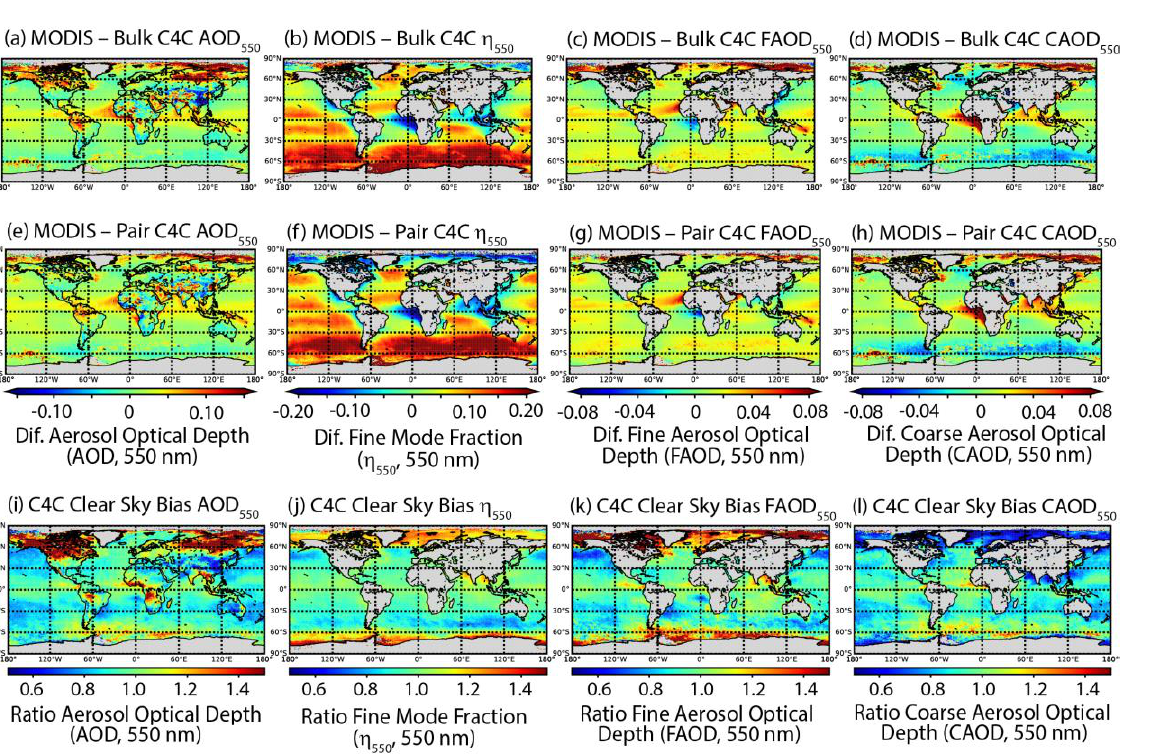
Figure 4. Latitudinal average values AOD components and differences of Aqua MODIS, Bulk ICAP C4C consensus, and pairwise sampled C4C consensus values to MODIS. ( a ) Total Aerosol Optical Depth (AOD 550 ); ( b ) Fine mode AOD (FAOD 550 ); ( c ) Coarse mode AOD (CAOD 550 ); and ( d ) the dif- ferences of pairwise C4C from Aqua MODIS. While the focus of this paper was on the maritime environment, terrestrial differences were reviewed for completeness, as these differences have implications for littoral skill.